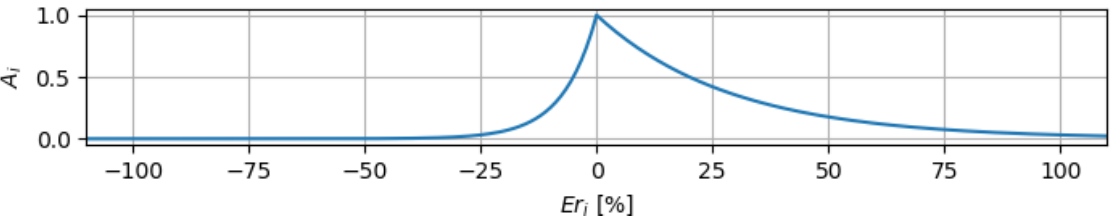
Figure 1. The weighted error Ai (Equation (2)) as a function of the relative error Er i . A negative Er i represents a longer estimated RUL than the actual RUL.